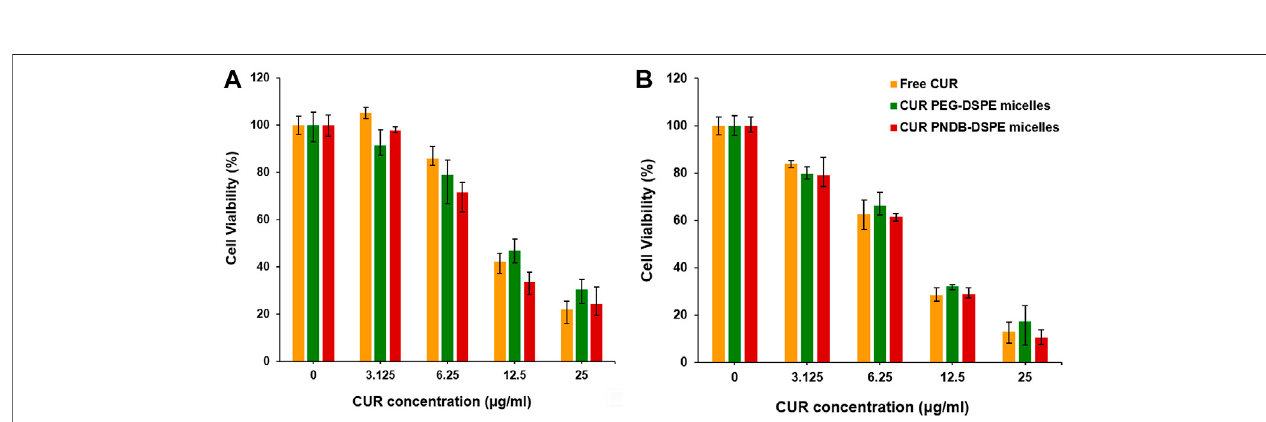
FIGURE 7 | Cytotoxicity evaluation of B16F10 cells incubated with free CUR, CUR-PEG-DSPE micelles, and CUR-PNDB-DSPE micelles for 24 h (A) and 48 h (B) at different CUR concentration levels ranging from 3.125 to 20 μ g mL − 1 .